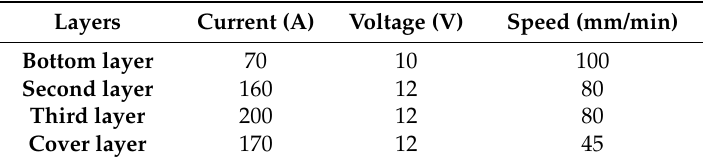
Table 2. Welding parameters of the four layers.